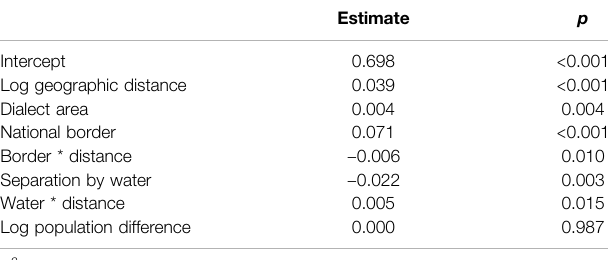
TABLE 7 | Multiple regression over distance matrices (MRM) results for the Clothing and personal hygiene domain.